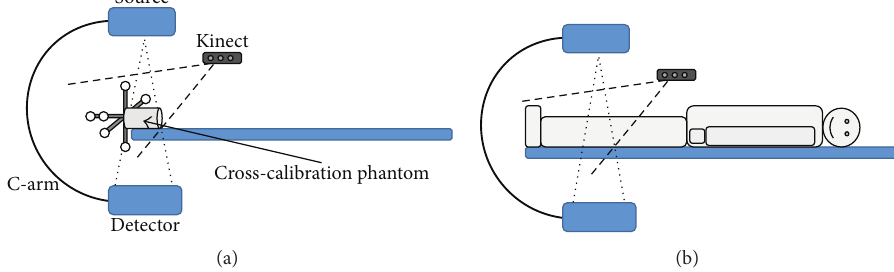
Figure 2: (a) A Kinect camera is cross-calibrated to the C-arm CT using a phantom on the patient bench. (b) For overexposure correction, the patient is imaged simultaneously by the C-arm and the Kinect.